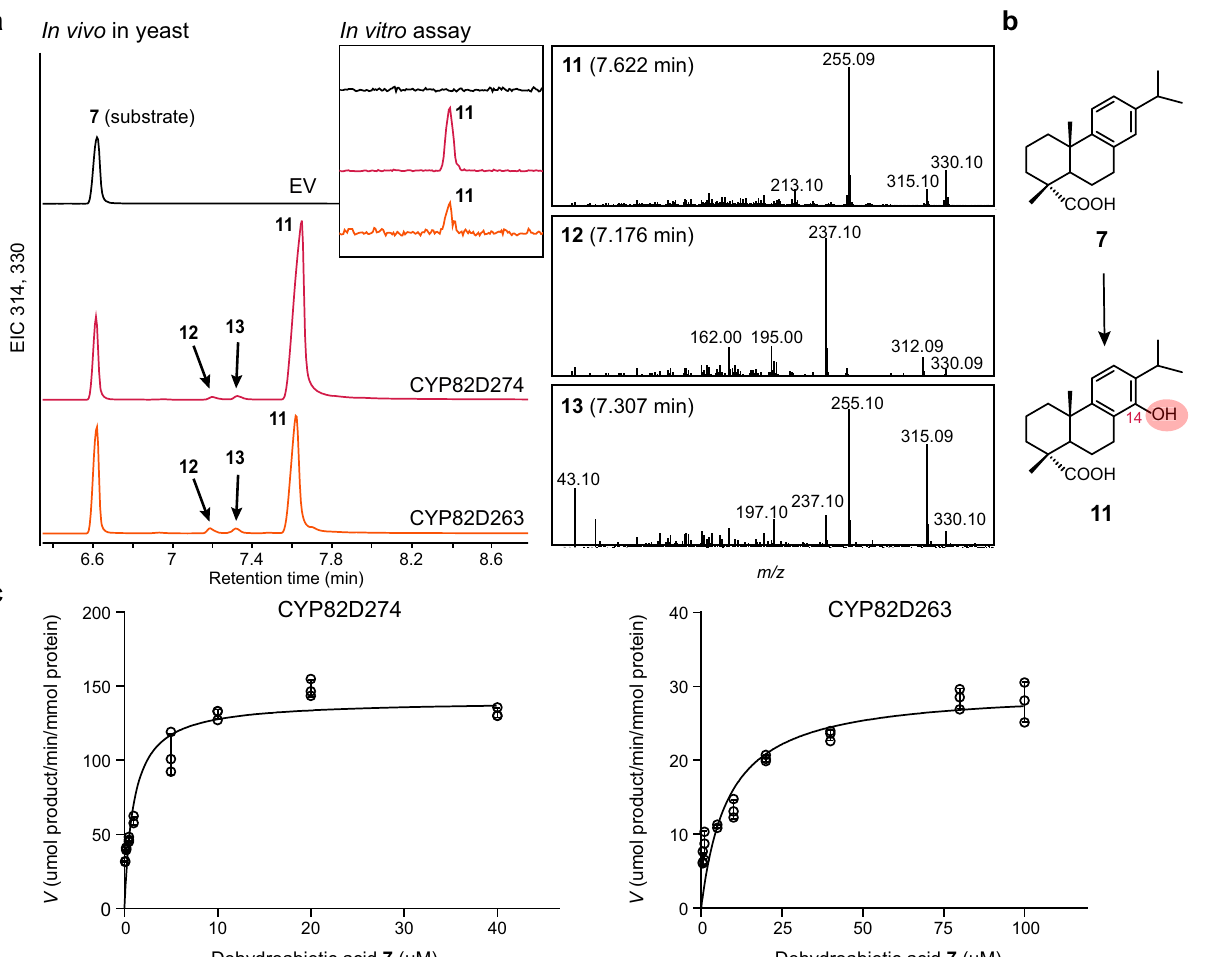
Fig. 3 | Functional characterization of CYP82D274 and CYP82D263. a GC ‒ MS analysis of methylated products of CYP82D274 and CYP82D263 catalyzing dehy- droabieticacid( 7 ) invivo orin vitro. Empty vector (EV)denotes yeasttransformed with an empty vector without CYP. b Catalytic process in a . c Kinetic pro fi les of CYP82D274andCYP82D263catalyzing 7 invitro.Thequanti fi cationof 11 wasbased on the standard curve y =0.7336x-0.014 ( R ²=0.9994) obtained by LC-TQ-MS/MS.